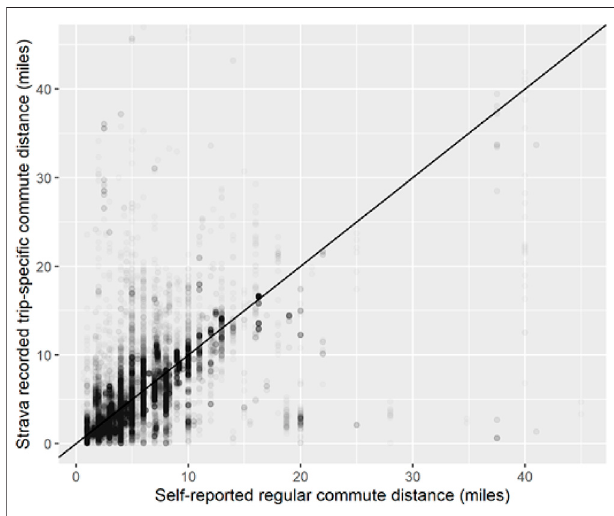
FIGURE 2 | Self-reported vs. Strava measured commute distance.